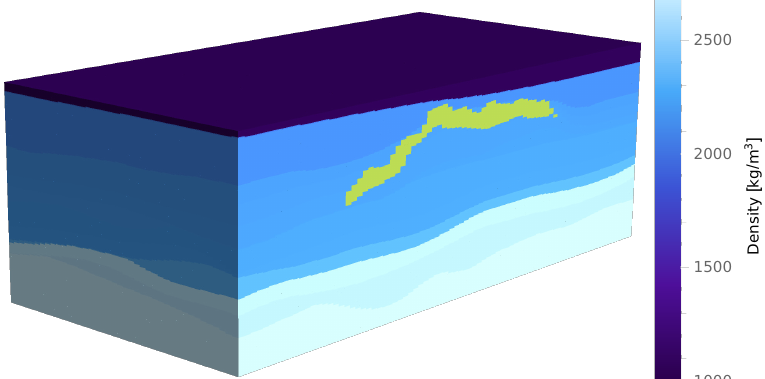
Figure 8. Cross section of three-dimensional model at X = 20 Km from the geological horizons shown in Figure 7. The color for salt ( ρ = 2200 kg/m 3 ) was modified to green to highlight the salt structure.